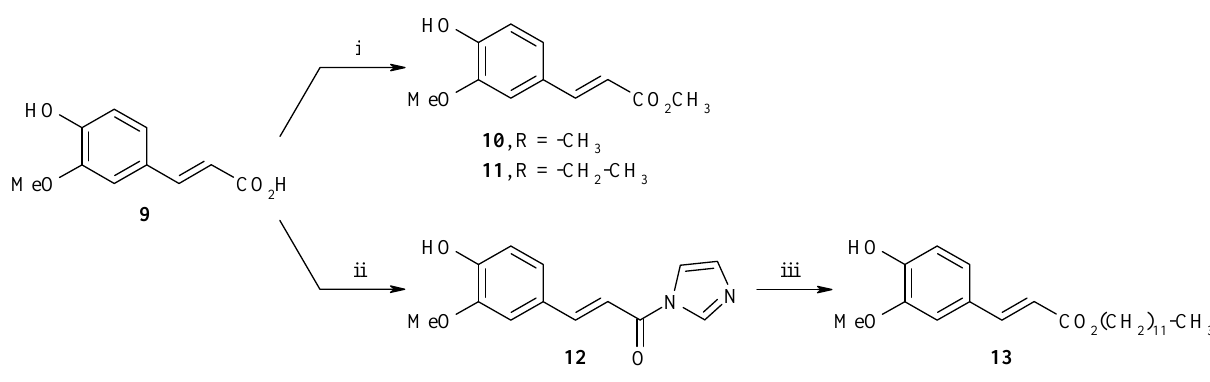
Scheme 6 : Synthesis of ferulate derivatives 10 , 11 and 13